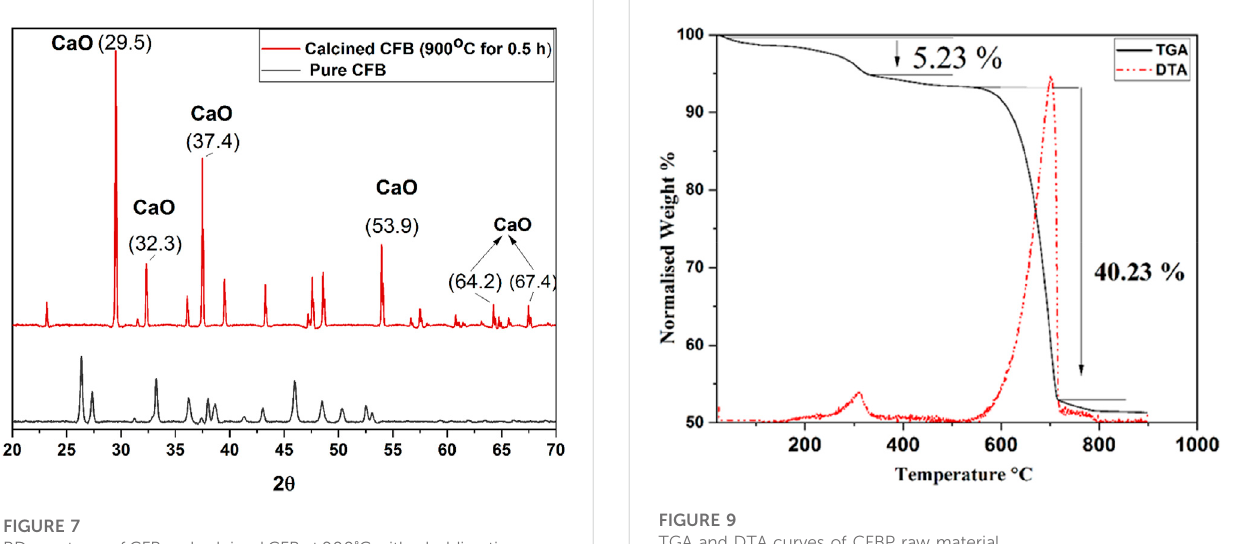
RDspectrumofCFBandcalcinedCFBat900 ° C withaholdingtime of 0.5 h.